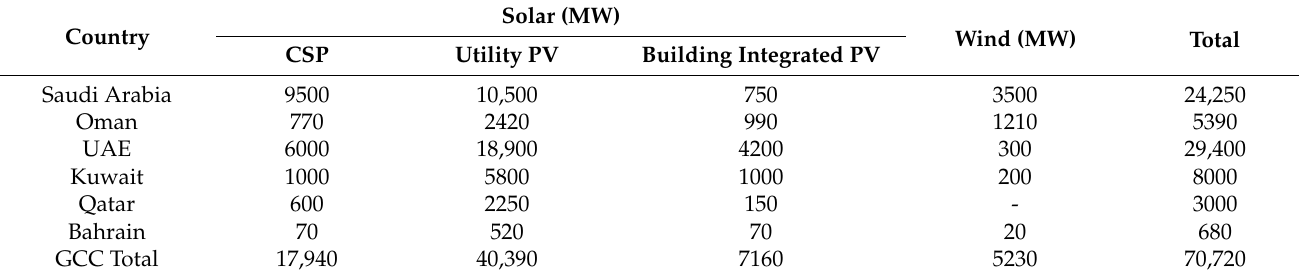
Table 4. Projected installed capacity in 2030 from solar and wind energy in the GCC region [25,112,113].